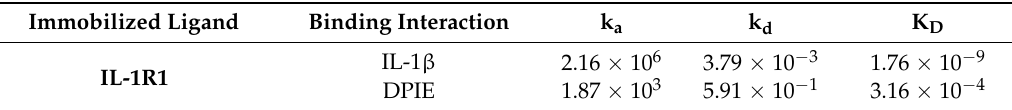
Table 1. Kinetic parameters of the binding of IL-1 β and DPIE to IL-1R1, analyzed by surface plasmon resonance (SPR).